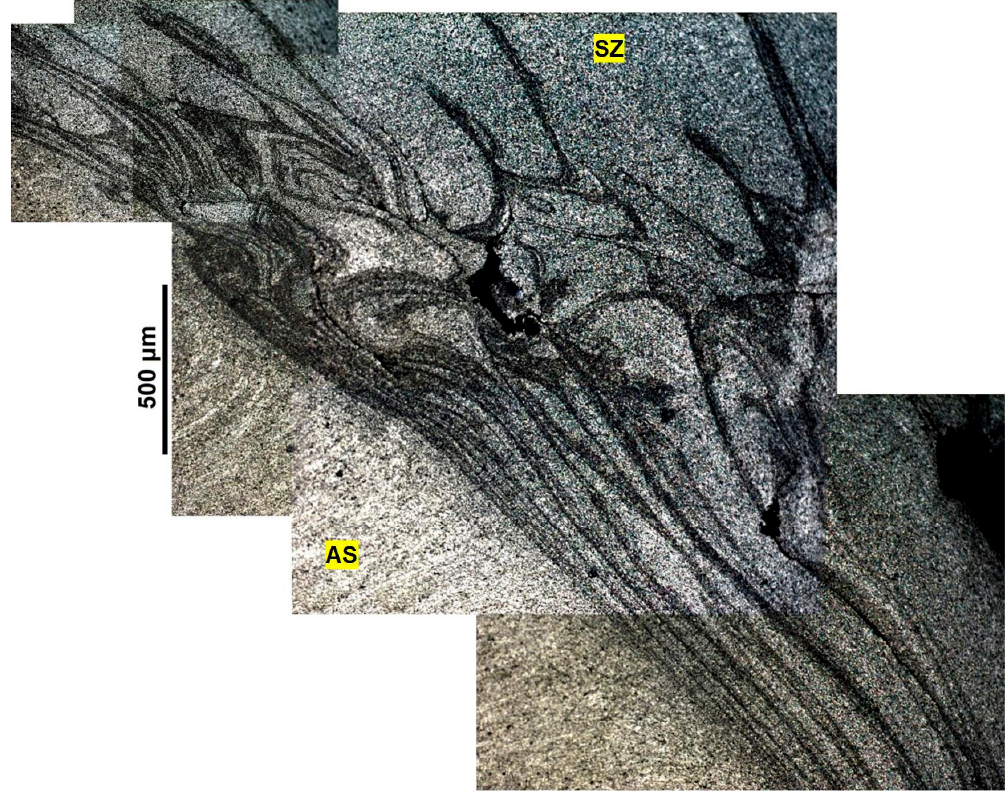
Figure 6. Interlaced flow patterns at the AS border of SZ as the following of the cascade microflow (Reagent C).